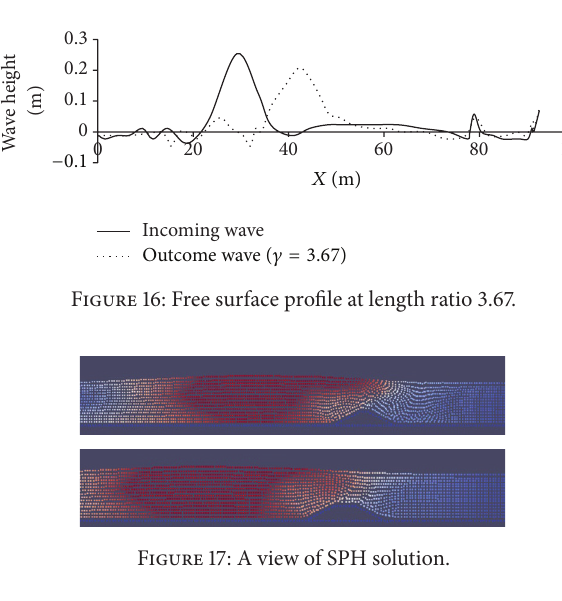
Figure 15: Free surface profile at length ratio 4.2.